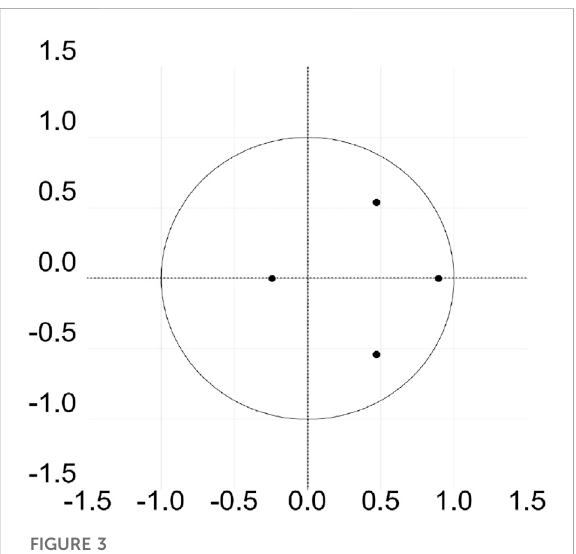
FIGURE 3 VAR model characteristic polynomial roots